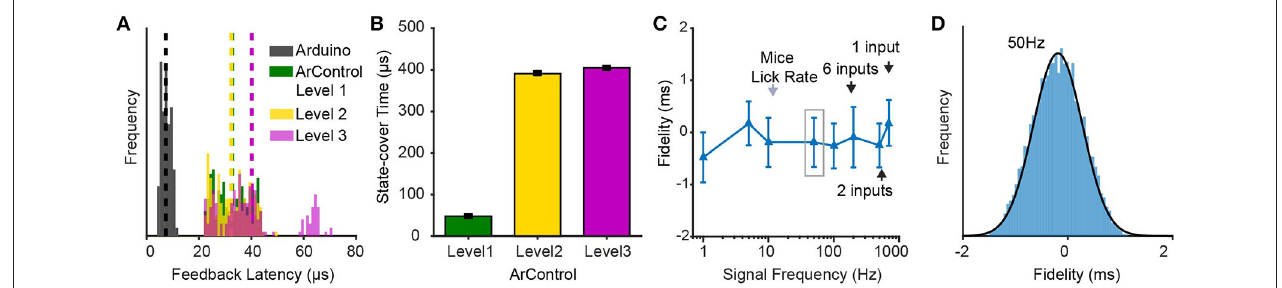
FIGURE 4 | Performance verifications of ArControl. (A) Feedback latency from detecting an input to delivering an output. Arduino represents the native Arduino environment. ArControl Level 1-3 are gradient tradeoffs between execution efficiency and data collection. (B) Time-consumption of an empty State. (C) DAQ ability in the ArControl Level 3 . Signals beyond the frequency (black arrow) fail to be accurately reported. (D) Details of the left gray box in (C) . Data are mean ± sd .